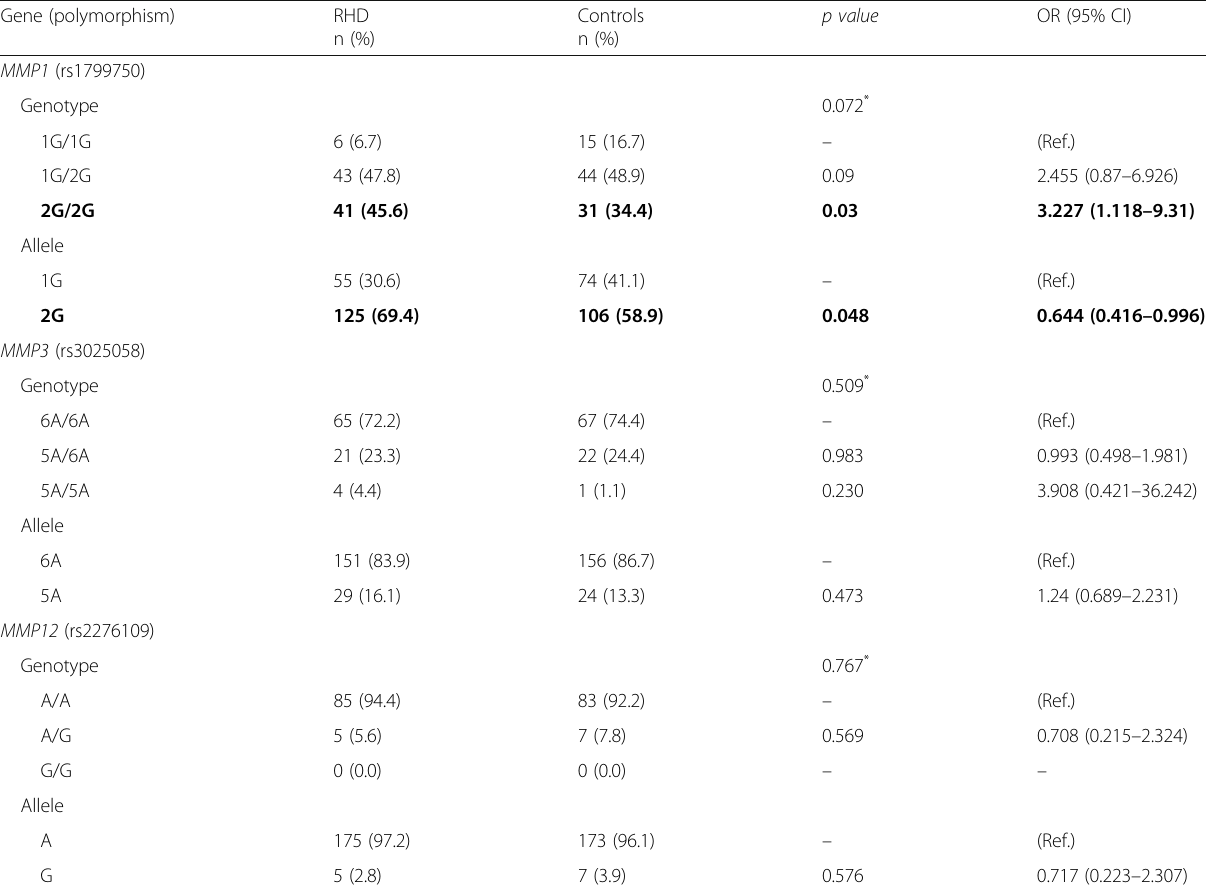
Table 3 Genotype and allele distributions of MMP1 , 3, and 12 polymorphisms Gene